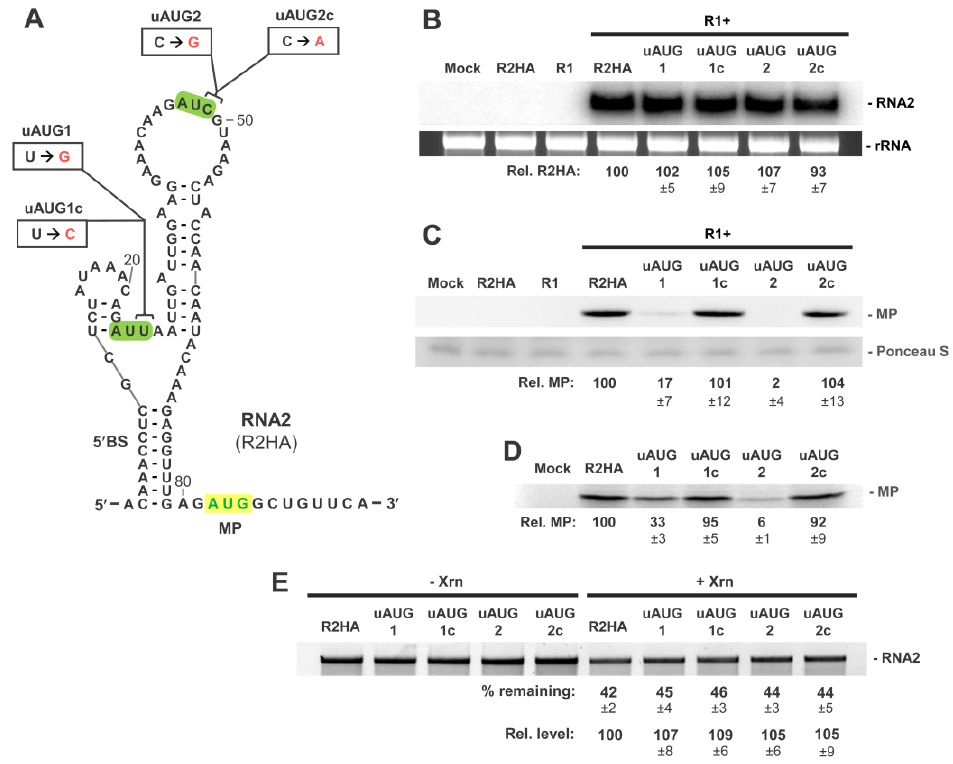
Figure 2. RNA2 upstream AUG (uAUG) mutants assessing 5 (cid:48) -end access. ( A ) RNA secondary structure of the 5 (cid:48) UTR of RNA2 with positions of single nucleotide substitutions that introduce out of frame upstream AUGs (uAUG1, uAUG2) or control non-AUGs (uAUG1c, uAUG2c). Nucleotide substitutions are shown in red and the positions of the uAUGs are highlighted in green. The AUG for the MP ORF is indicated in green nucleotides highlighted in yellow. ( B ) Northern blot analysis of protoplast infections of wt RNA1 (R1) and RNA2 mutants. The position of RNA2 is denoted on the right-hand side along with rRNA loading controls. Relative levels of genome accumulation compared to R2HA (set at 100) are shown with SEMs (n = 3). ( C ) Corresponding Western blot analysis of protoplast infections depicted in panel ( B ). The position of the MP is denoted on the right-hand side along with Ponceau S staining loading controls. Relative levels of MP accumulation normalized to corresponding RNA levels, with that for R2HA set at 100, are shown with SEMs (n = 3). ( D ) In vitro translation in wheat germ lysate of R2HA and uAUG mutants. Relative levels of MP accumulation compared to R2HA (set at 100) are shown with SEMs (n = 3). ( E ) In vitro Xrn1 treatment of R2HA and uAUG mutants. Percentages of input RNA remaining (% remaining) and relative levels (Rel. levels) of RNA remaining compared to R2HA (set at 100) are shown with SEMs (n = 3). The uAUGs and corresponding non-uAUG controls were introduced into the 5 (cid:48) UTR of R2HA (an RNA2 variant encoding a C-terminally HA-tagged MP) by